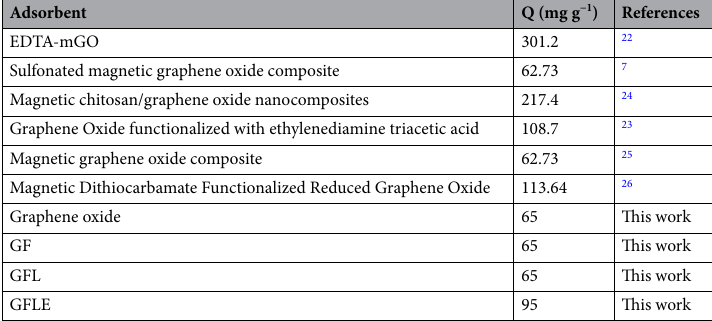
Table 11. Comparison of sorption capacities of several adsorbents for Cu (II) ions.